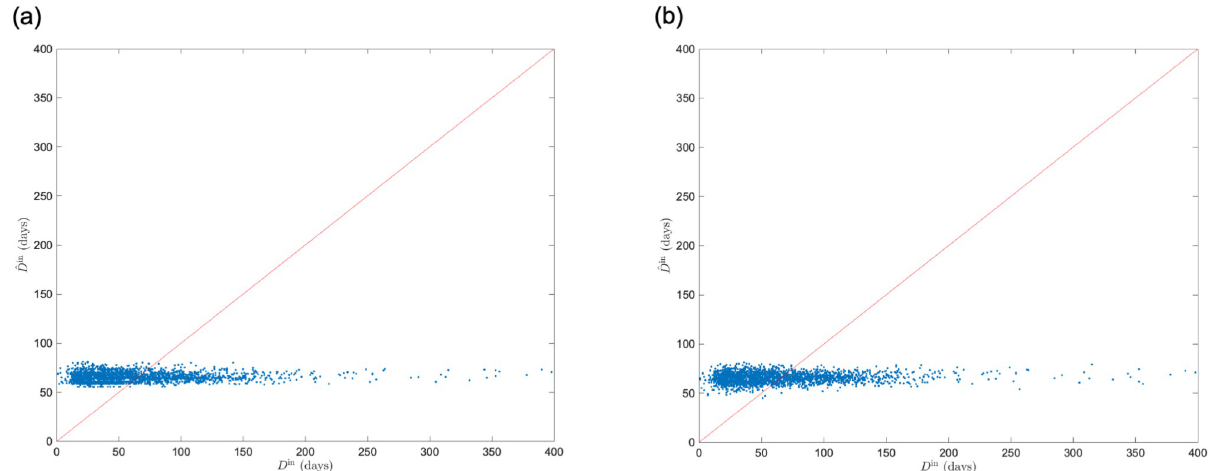
Fig 7. Comparison of measured duration of hospital stay D in and predicted the duration of of hospital stay ^ D in by linear regression model with geometric mean of strength μ ( s ) and age as input variables. (a) μ ( s ). (b) μ ( s ) and age. ^ D in obtained by five-fold cross validation is shown. Both are G G G underfitting and do not fully explain the variation in D in .